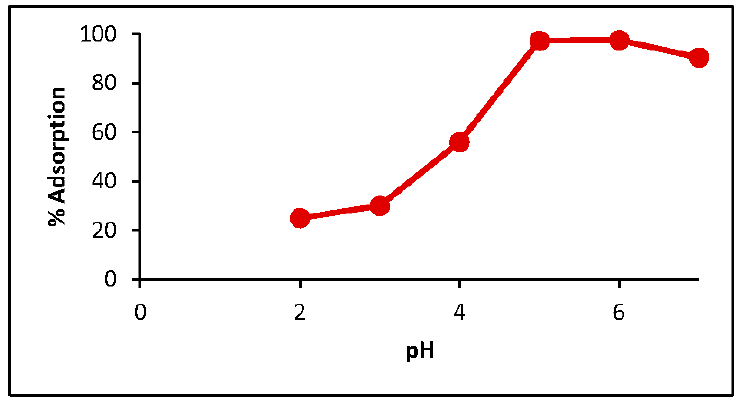
Figure 3. Effect of pH on Cu 2+ adsorption onto CMK ‐ 3 (at 25 °C, m = 20 mg and [Cu 2+ ] = 30 ppm) .